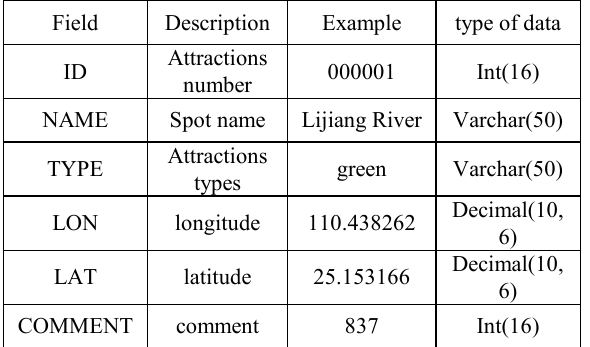
Table 2. Tourist attraction data table